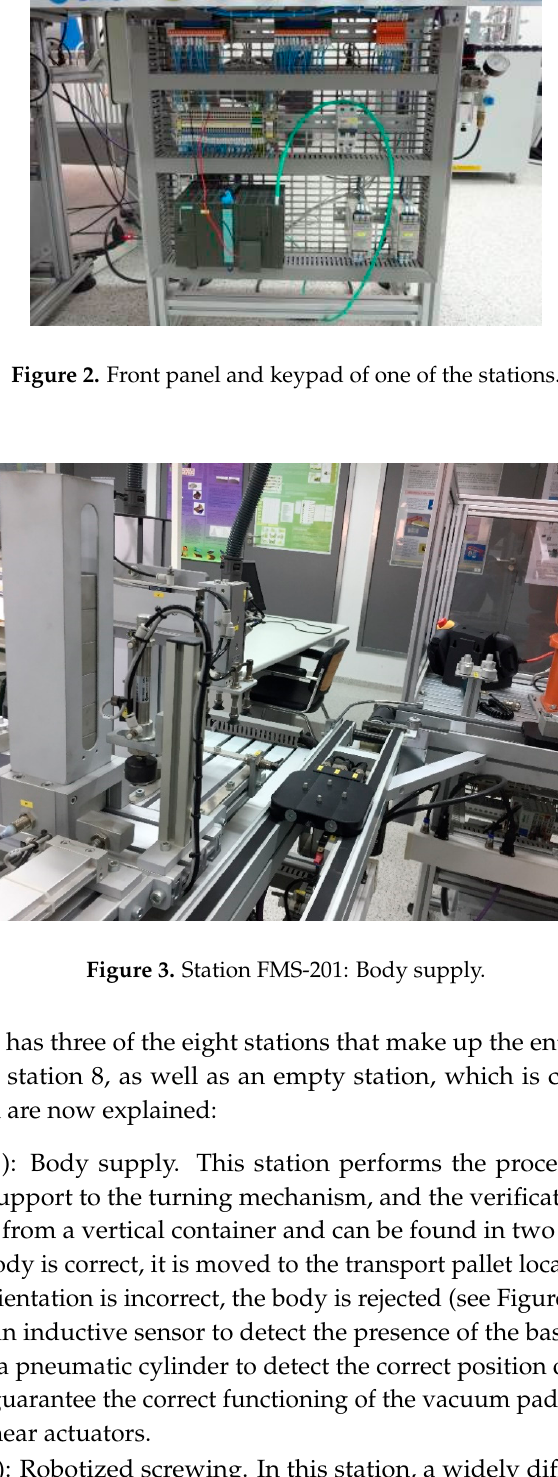
( b ) Figure 1. Detail of pieces managed in the FMS: ( a ) Constituent elements of the turning mechanism; ( b ) Transport pallet. Each of the stations is constituted by a table-like structure on which the different components of